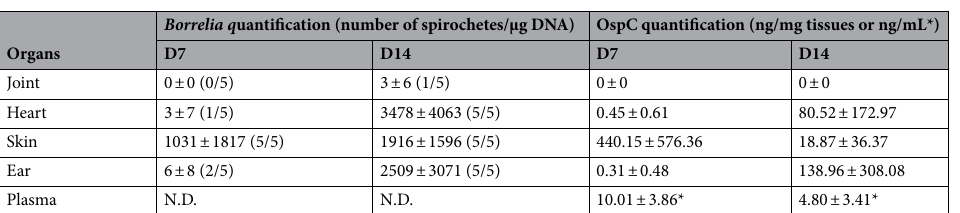
Table 3. Quantification of Borrelia and OspC in mouse tissues and plasma at the 7 and 14 days post- inoculation. The quantity of B. burgdorferi in tissues was estimated by qPCR using the standard curve method (Fig. S1). The numbers in parentheses indicate the number of positive mice/number of mice tested. N.D.: not determined. OspC was measured by C10 peptide SPIE-IA. Data are presented as means ± SEM (5 infected mice per group for tissues and 10 and 7 infected mice at 7 and 14 days respectively for